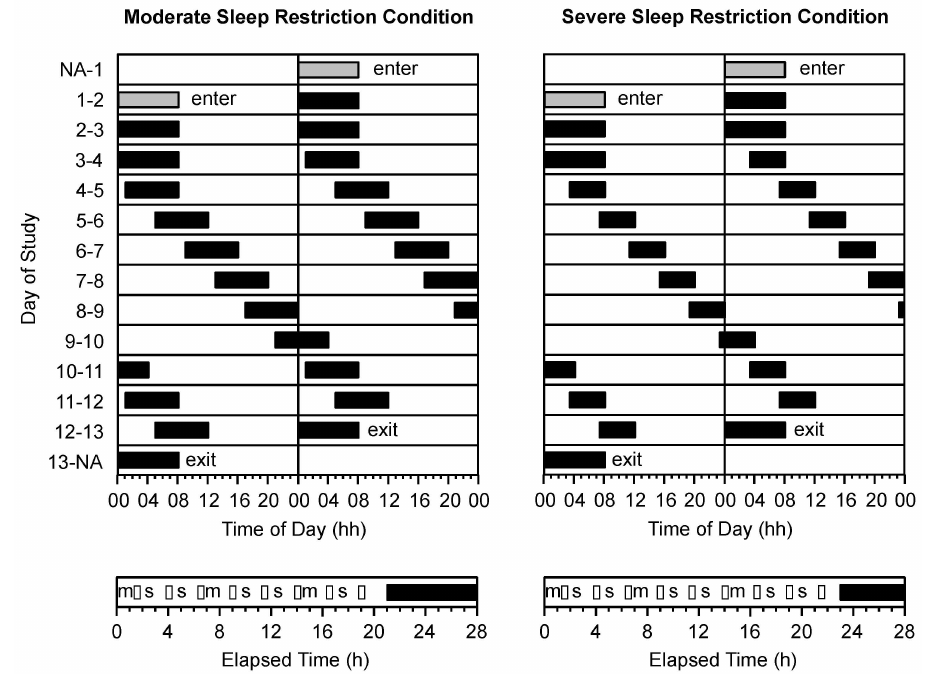
Figure 1. Double raster plot of the study protocol in the moderate sleep restriction condition ( top left panel ) and the severe sleep restriction condition ( top right panel ). The vertical axis represents calendar day of study. The horizontal axis represents the time of day and is 24 h in length. Grey bars represent time in bed on baseline days. Black bars represent time in bed on forced desynchrony days in the moderate sleep restriction condition (equivalent to 6 h time in bed/24 h) and the severe sleep restriction condition (equivalent to 4 h time in bed/24 h). The timing of (m) meals, (s) snacks and ( ‚ ) test batteries are illustrated as a function of elapsed time into the wake period in the moderate sleep restriction condition ( bottom left panel ) and the severe sleep restriction condition ( bottom right panel